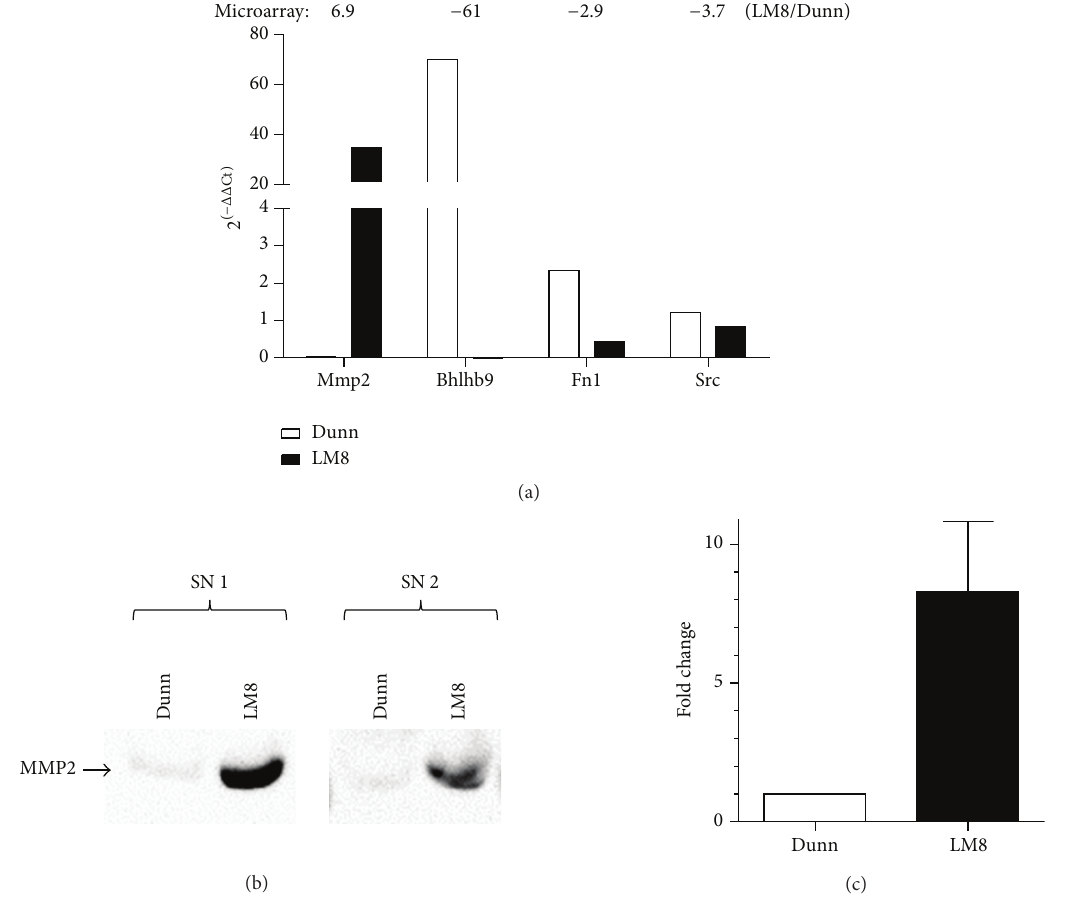
Figure 2: (a) qRT-PCR analysis of Mmp2, Bhlhb9, Fn1, and Src mRNA expression normalized to Gapdh in Dunn and LM8 cells. For comparison the fold-change values calculated from the microarray data are indicated above the graph. (b) Representative western blots of MMP2 protein levels in FCS-free supernatant of Dunn and LM8 cells and (c) quantitative analysis of three independent western blots experiments. Results are shown as the means ±